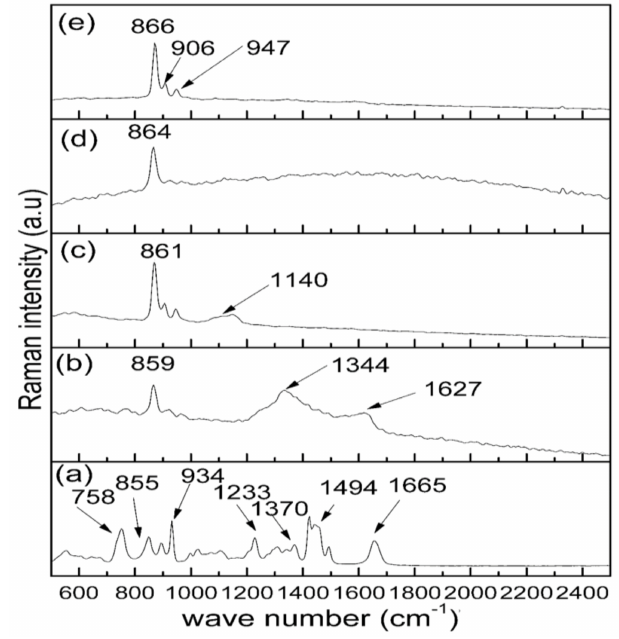
Figure 2. Raman spectra of ( a ) uncalcined sample and willemite NPs calcined at 900 ◦ C over a range of